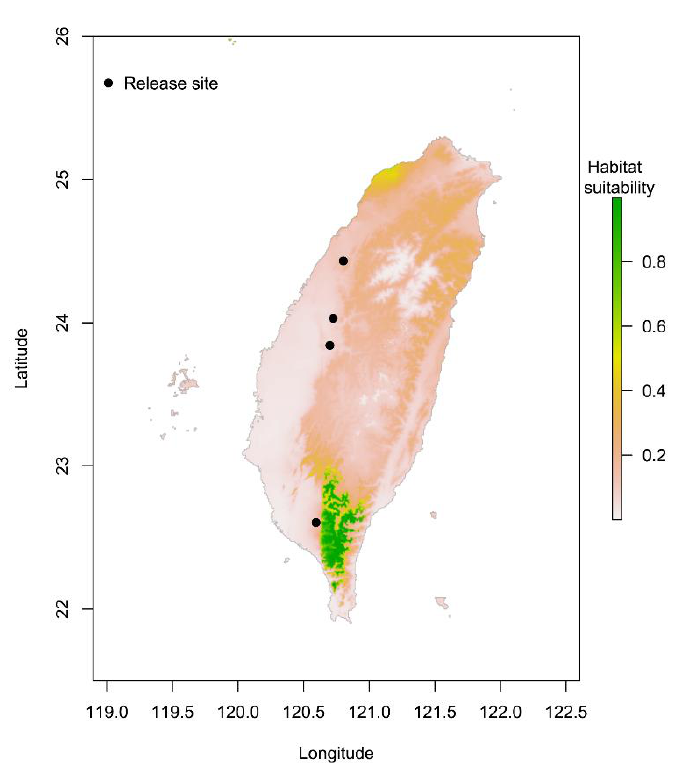
Figure 3. Comparison of potential distribution areas and four release sites of Phytoseiulus persimilis in Taiwan.